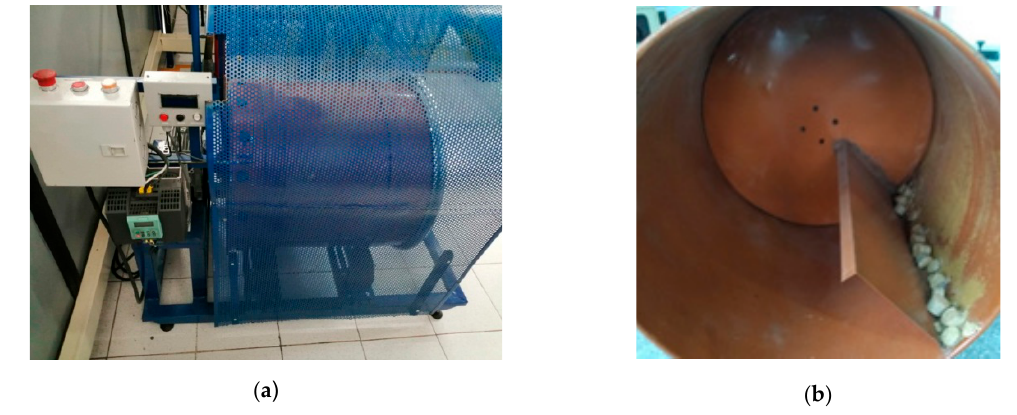
Figure 1. Equipment for briquette durability tests. ( a ) Side view of the equipment. ( b ) Front view with briquette load